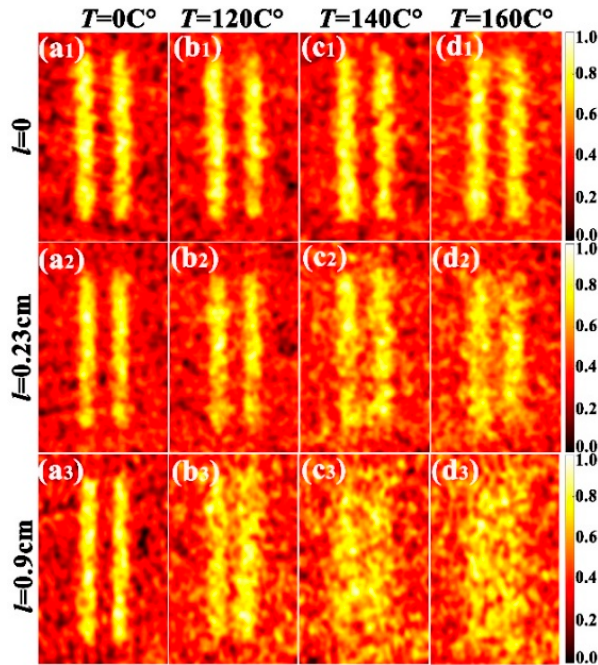
Figure 7. Normalized ghost image of a double slit with different l and temperatures of the hot plate. ( a 1 – a 3 ): (cid:1846) = 0 ℃ , ( b 1 – b 3 ): (cid:1846) = 120 ℃ , ( c 1 – c 3 ): (cid:1846) = 140 ℃ and ( d 1 – d 3 ): (cid:1846) = 160 ℃ . ( a 1 – a 3 ): T = 0 , ( b 1 – b 3 ): T = 120 , ( c 1 – c 3 ): T = 140 and ( d 1 – d 3 ): T = 160